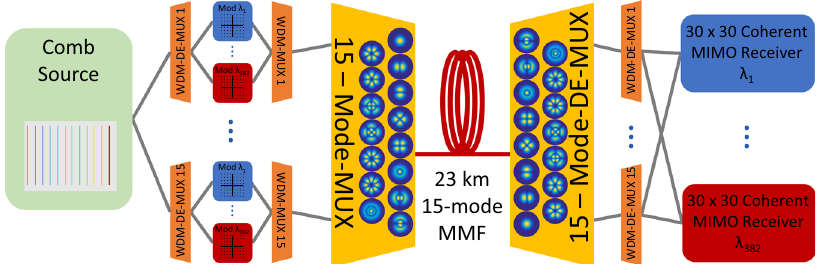
Fig. 1 Schematic diagram of the optical transmission system. A total of 382 laser lines were generated by an optical comb source to generate 15 × 382 independent dual-polarization 64-QAM data signals. Each set of 382 WDM signals was spatially multiplexed on a different fi ber mode and jointly transmitted over a 15-mode fi ber. After spatial de-multiplexing, each spatial super-channel, formed by the 15 spatial channels of the same wavelength, was received by a 30 × 30 coherent MIMO